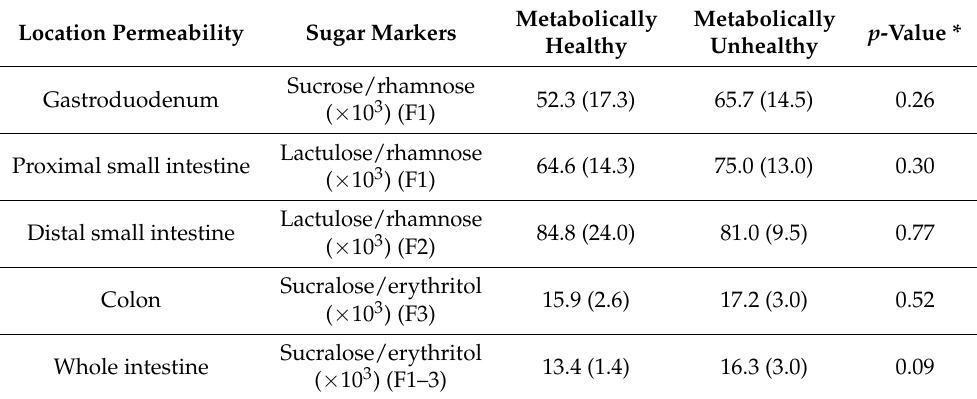
Table 4. Urinary sugar ratios of metabolically healthy ( n = 14) and metabolically unhealthy ( n = 14) subjects after an acetylsalicylic acid challenge.